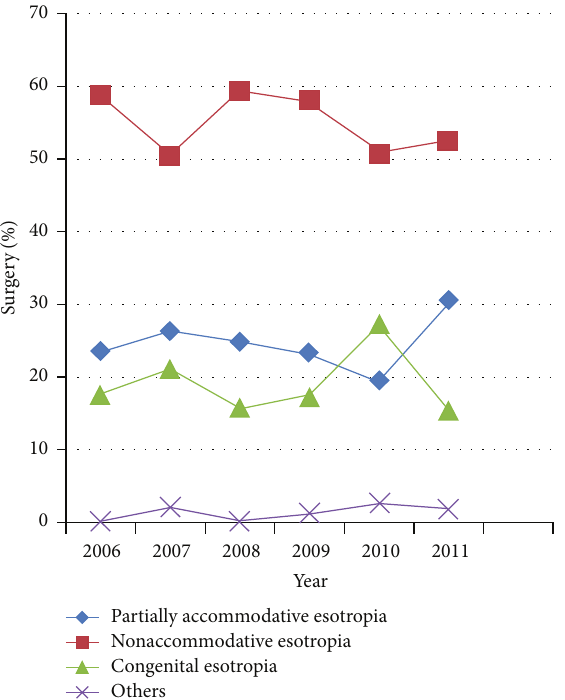
Figure 4: Distribution of the concomitant esotropia